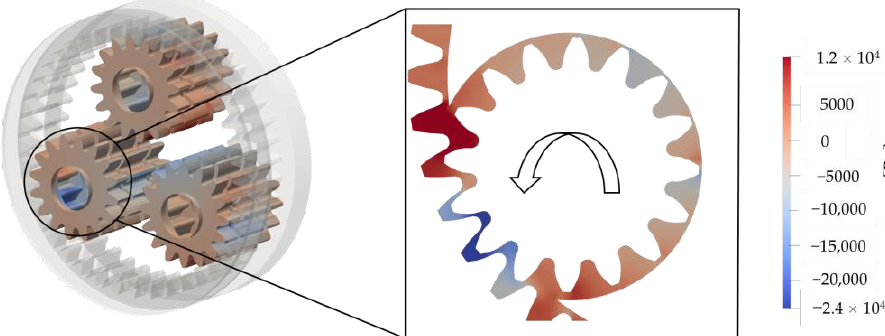
Figure 13. Pressure contour on the wheels.